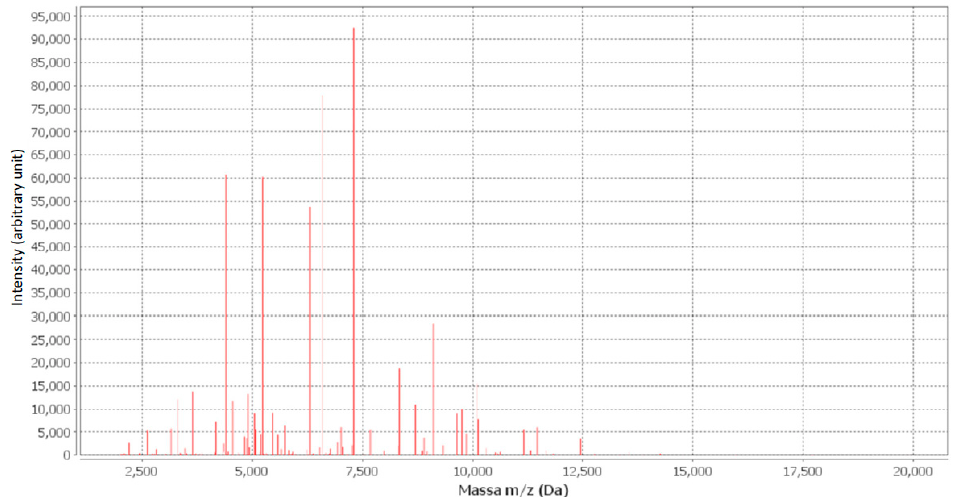
Figure 1. Maldi-TOF spectra of bacterial isolates from blood sample, using myla data processing it was identified as Ralstonia pickettii .